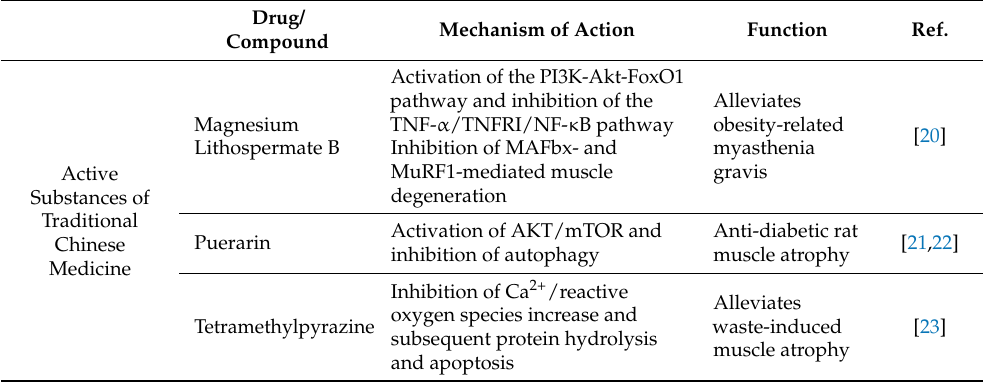
Table 1. Drugs in the treatment of skeletal muscle atrophy.